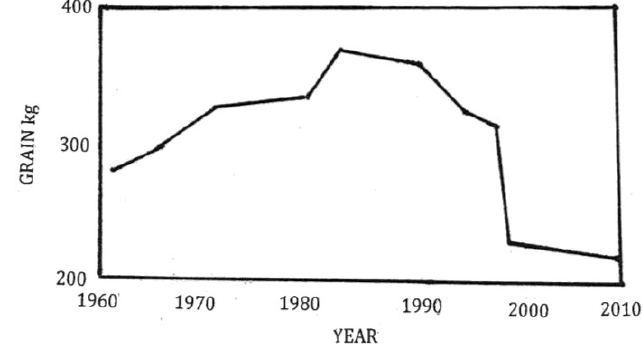
Figure 3. Cereal Grain Production per capita in the world from 1961 to 2010